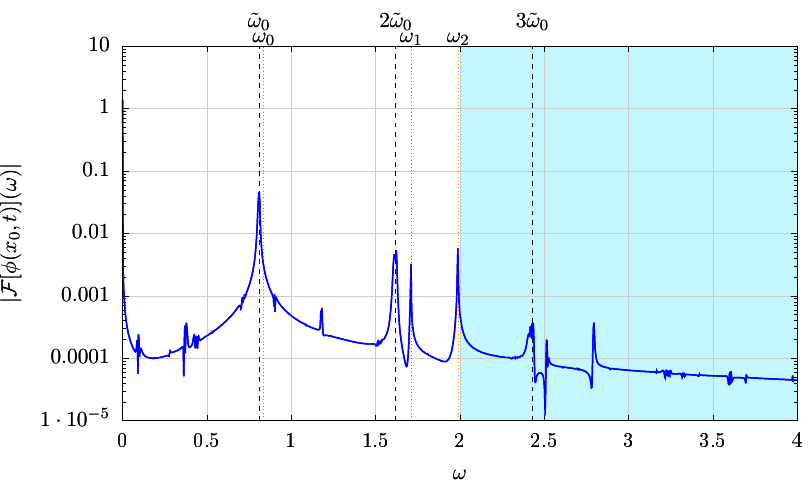
Figure 26 . Power spectrum of the (cid:12)eld after the collision (cid:22) K + K 0 for (cid:11) = (cid:0) 1 : 05, v = 0 : 2 measured at x = x 0 = (cid:0) 2. Eigenfrequencies of the kink ! i and multiplicities of the basic frequency n ~ ! 0 are also